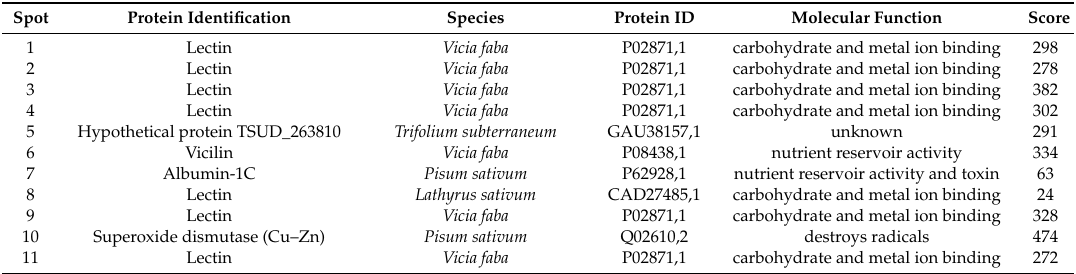
Table 3. Albumin identification fraction by LC-MS-MS / MS.